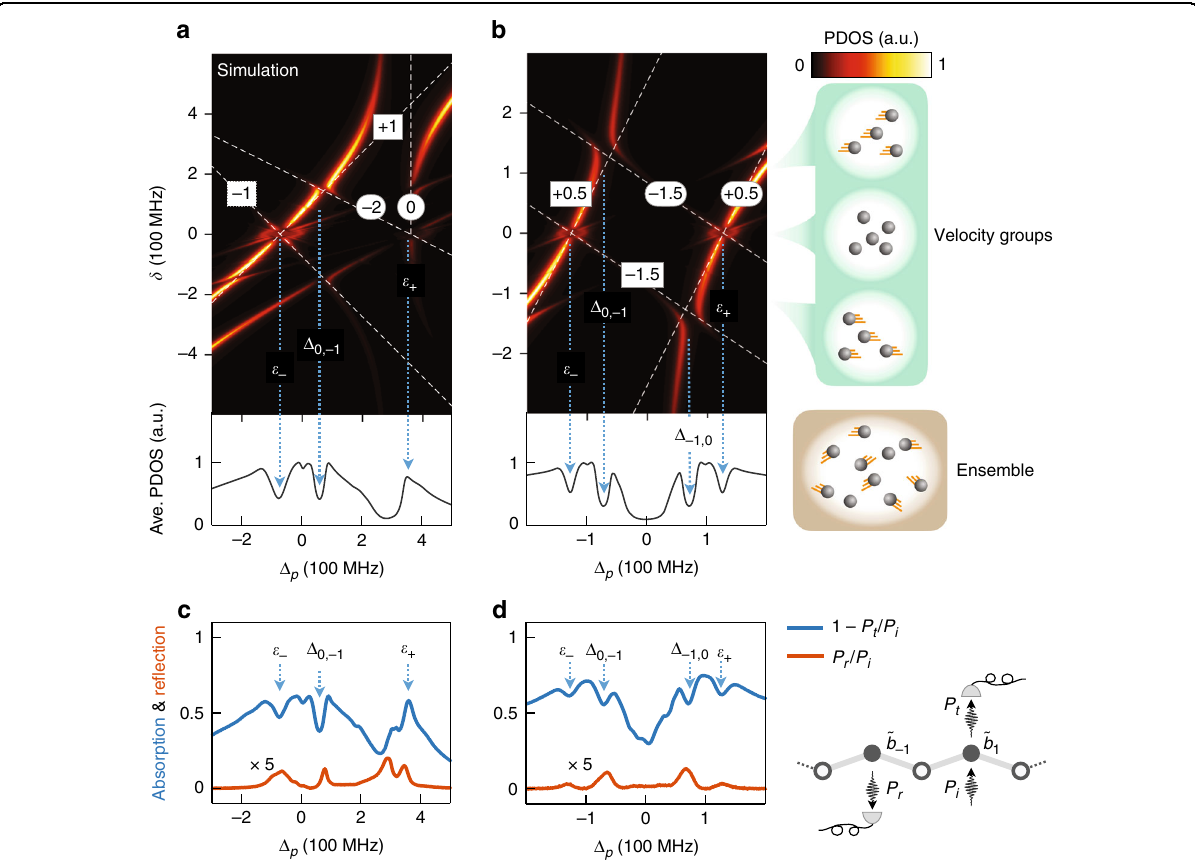
Fig. 2 Wannier-Stark ladders and the absorption spectra. a , b The upper panels are numerical simulation of the PDOS as functions of the Doppler shift δ and probe detuning Δ p . The averaged PDOS in the lower panels are obtained from upper panels by integrating δ (in Maxwell distribution with FWHM 500 MHz). c , d The experimental data of the absorption (1 (cid:4) P t = P i ) and re fl ection ( P r = P i ) spectra, where P i , P t , and P r are the power of the incident, transmitted, and re fl ected probe fi elds, respectively. a , c The Semenoff insulator with Ω 1 ¼ Ω 2 ¼ 120 MHz and Δ c ¼ 298 MHz. b , d The SSH model ( Δ c ¼ 0) with Ω 1 ¼ 125 MHz, Ω 1 = Ω 2 ¼ 5 : 3. The white dashed lines indicate the uncoupled WSLs in Eq. (5). The highlighted numbers denote the values of r ½ n (cid:6) (cid:4) (square) and r ½ m (cid:6) þ (round) of the corresponding WSLs. Both in the simulated averaged PDODs and the measured absorption spectra, the dips and peaks capture the band centers (denoted by ϵ ± ) and anti-crossing points (denoted by Δ n ; m ), where the blue dotted lines are used to guide eyes. The arrows point to the local extrema of the corresponding spectral